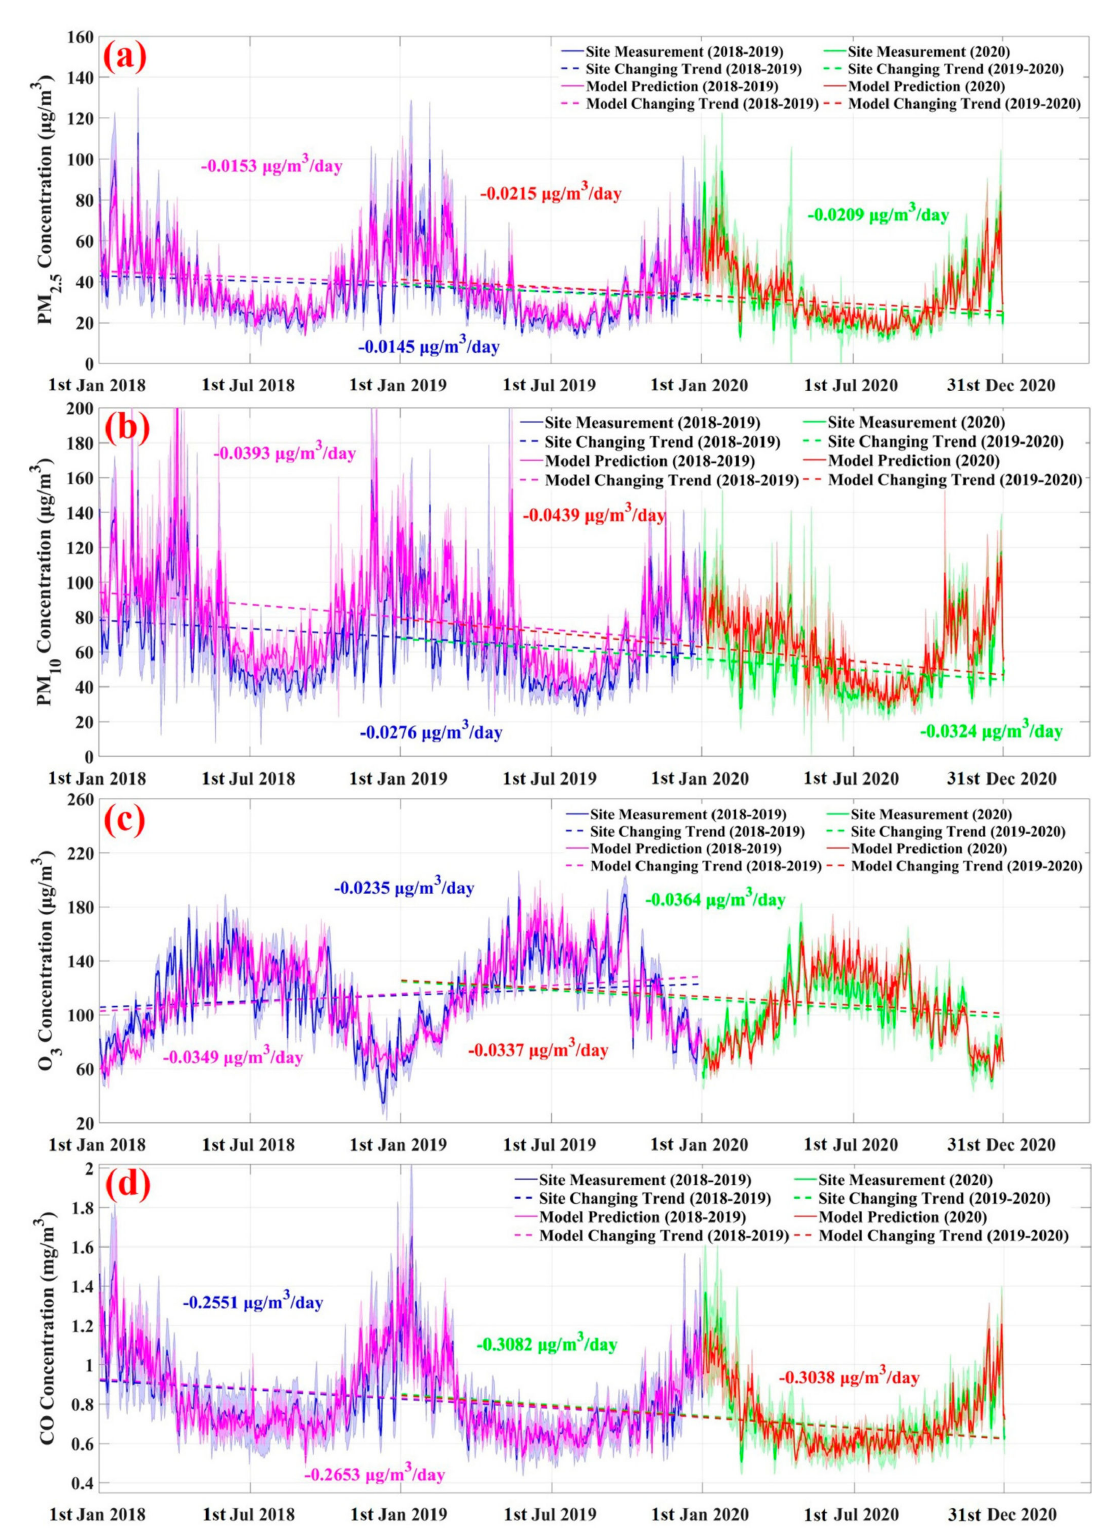
Figure 10. The three-year time series changes of daily PM 2.5 , PM 10 , O 3 , and CO concentration based on site measurement and model prediction from 1 January 2018 to 31 December 2020 over the Central and Eastern China. ( a ) The changes for PM 2.5 ; ( b ) PM 10 ; ( c ) O 3 ; ( d )